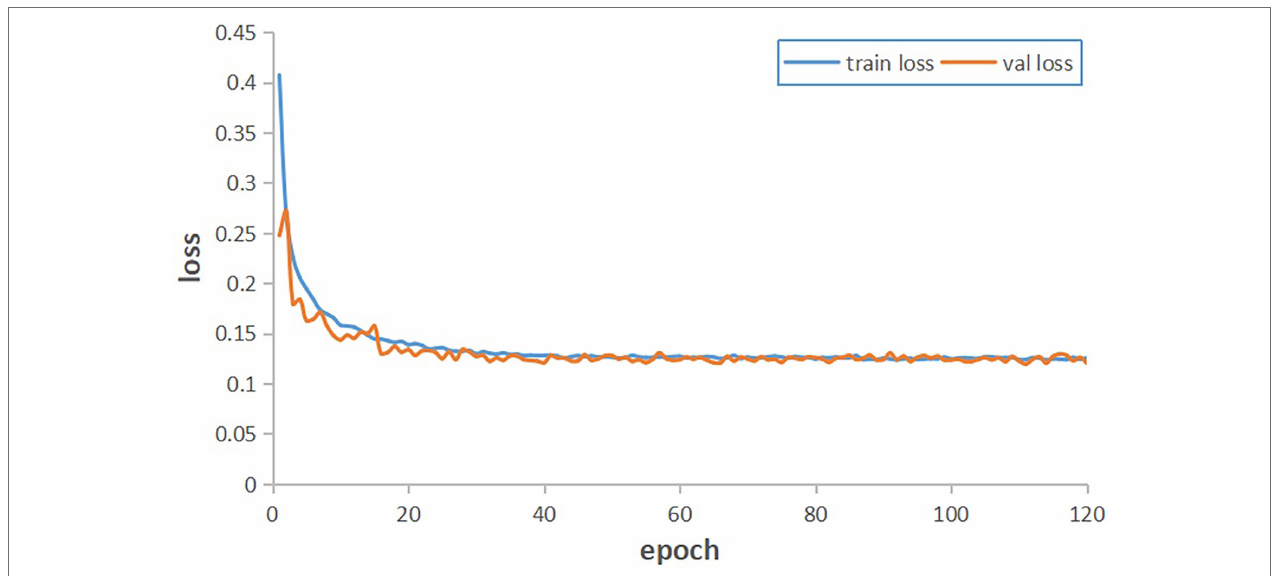
FIGURE 6 | Improved DeepLab v3+ training